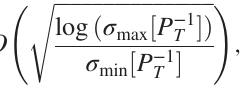
ˆ B Þ (blue dashes)